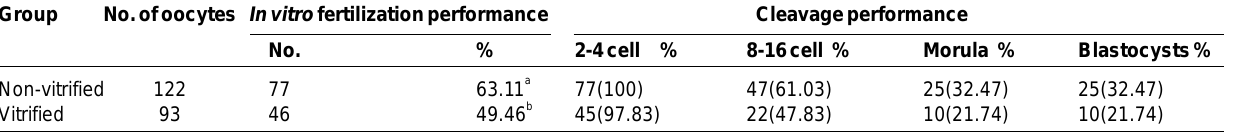
Group No. of oocytes In vitro fertilization